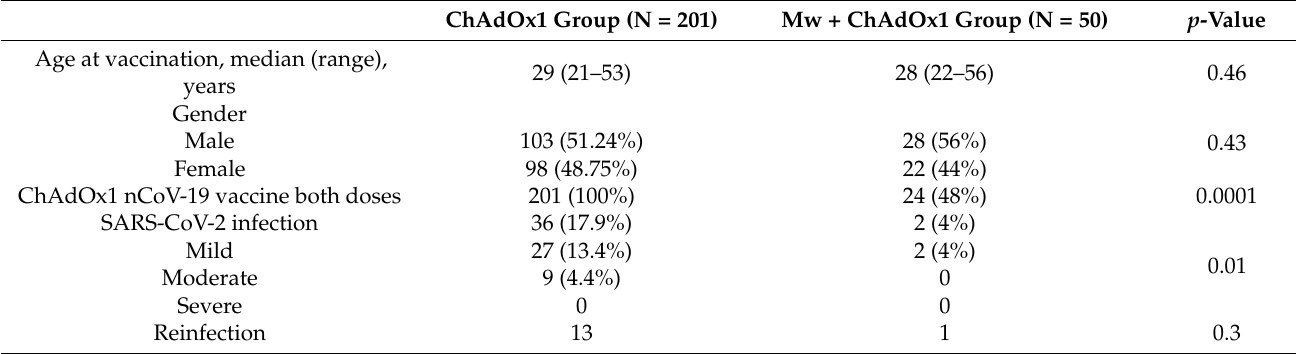
Table 1. Characteristics and